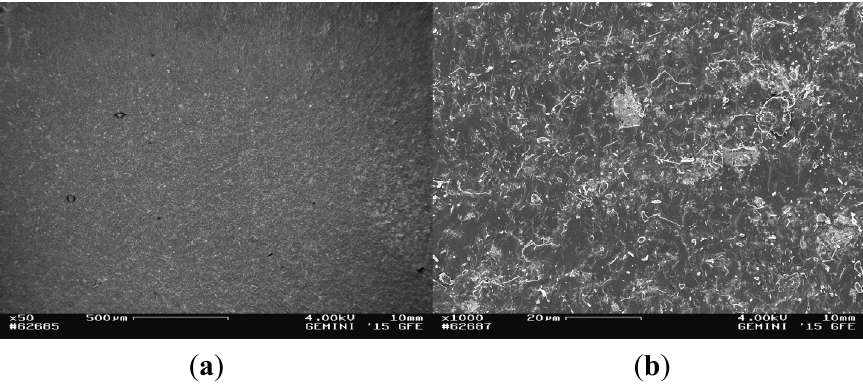
Figure 11. SEM images of the glass solder area of the fractured surface of the ceramic cylinder of compound sample 5 (5_ATZ_gs) at magnifications of ×50 ( a ) and ×1000 ( b ).